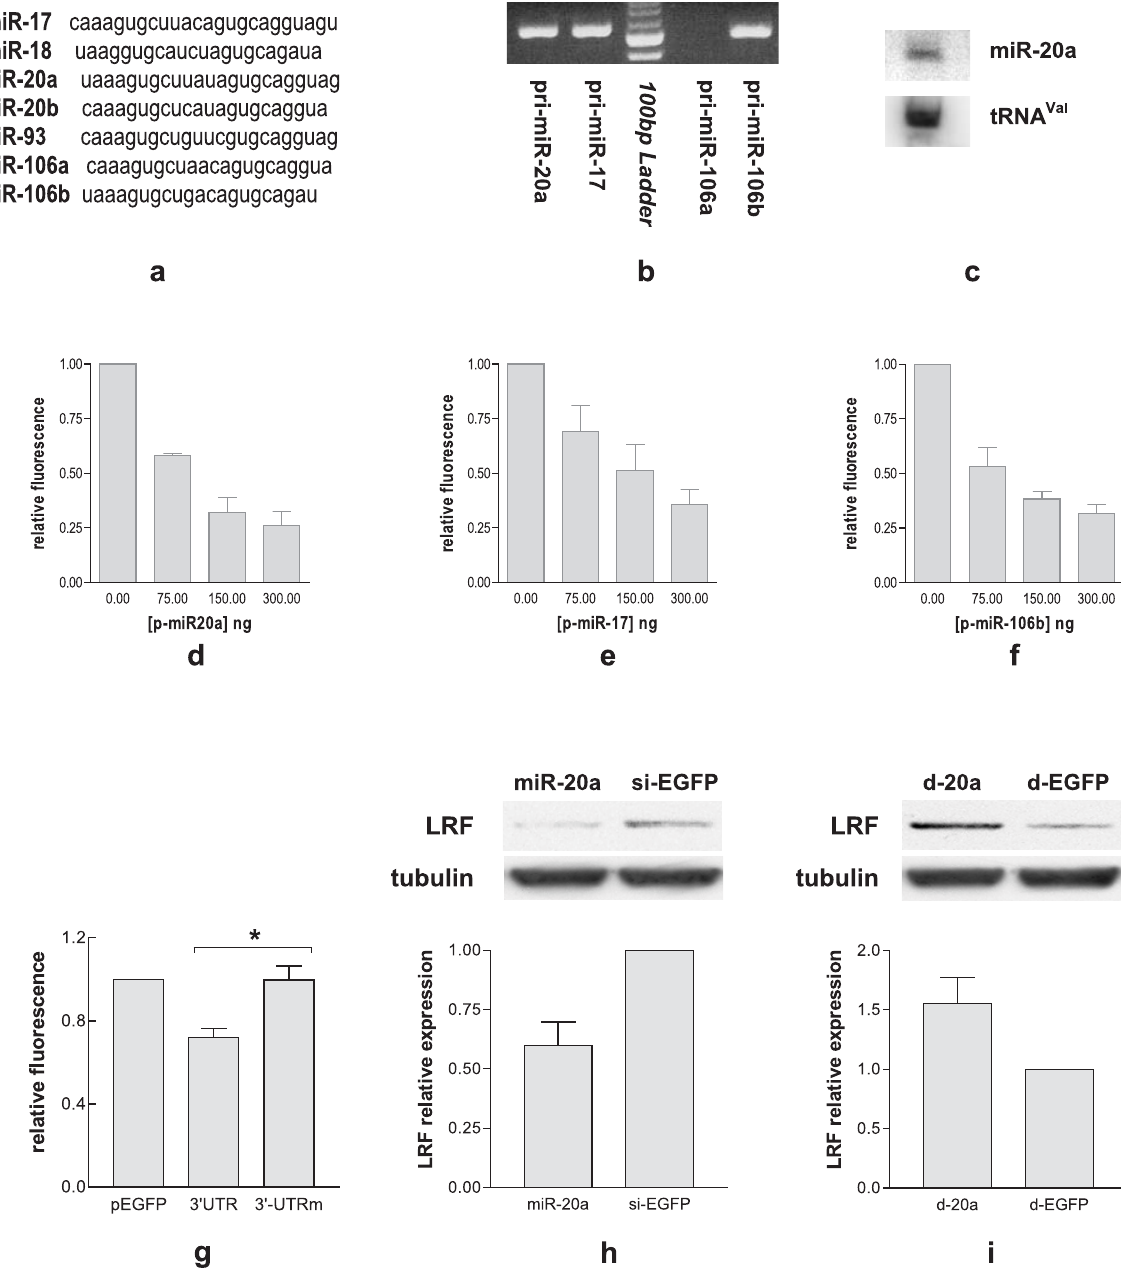
Figure 1. miR-20a regulates LRF expression in MEF. a: Sequences of miRNAs belonging to miR-17 family; b: RT-PCR analysis of pri-miRNA expression in MEF. Total RNA was extracted and amplified by RT-PCR using appropriate primers. The PCR products of , 500 bp length are pri-miRNAs of the miR-17 family; c: Northern blot analysis of mature miR-20a expression in MEF. 20 m g of total RNA was analyzed with miR-20a probe or valine tRNA control probe; d, e, f: Interaction between 3 9 UTR of mmu - zbtb7a mRNA and miR-17 family. HEK293T cells were co-transfected with p- zbtb7a 3 9 UTR and increasing concentrations of p-miR-20a, p-miR-17 p-miR-106b or p-miR-26a control plasmid. 24 hours after transfection, cells were collected and the EGFP fluorescence intensity of each sample was determined with a FACscan analyzer. The relative expression of p- zbtb7a 3 9 UTR was obtained by the ratio of the mean fluorescence value of HEK293T cells transfected with p-miR-20a, p-miR-17 or p-miR-106b and the mean fluorescence value of HEK293T cells transfected with p-miR-26a control plasmid. Each bar represents the mean 6 SE of three independent experiments; g,: Transfection of p-miR-20a with either p- zbtb7a 3 9 UTR or p- zbtb7a 3 9 UTR m in HEK293T. Cells were collected 24 hours after transfection and the EGFP fluorescence intensity of each sample was determined with a FACscan analyzer. The relative expression was obtained by the ratio of the mean fluorescence values of HEK293T cells cotransfected with p-miR-20a and either p- zbtb7a 3 9 UTR or p- zbtb7a 3 9 UTR m normalized to that of HEK293T cells transfected with pEGFPC1. Each bar represents the mean 6 SE of three independent experiments. h i: Effects of over- expression/depletion of miR-20a on LRF expression.